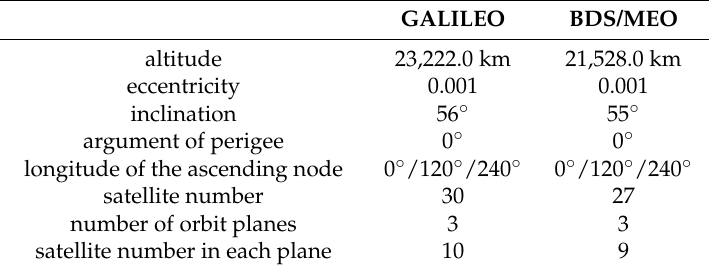
Table 1. The orbit parameters of the simulated full GALILEO and BDS MEO